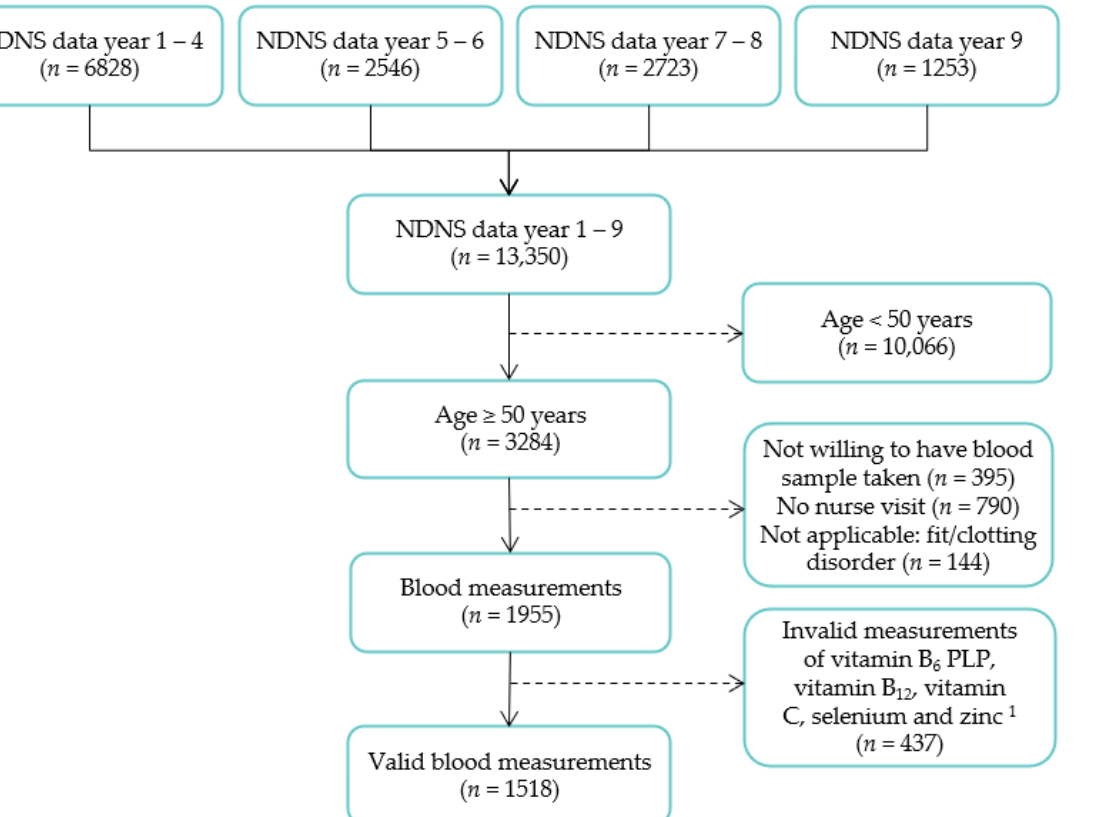
Figure 2. Flowchart of the study population for analyses. 1 Reasons for invalid measurements included an incomplete blood volume, notional results, incorrect labelling and insufficient sample for